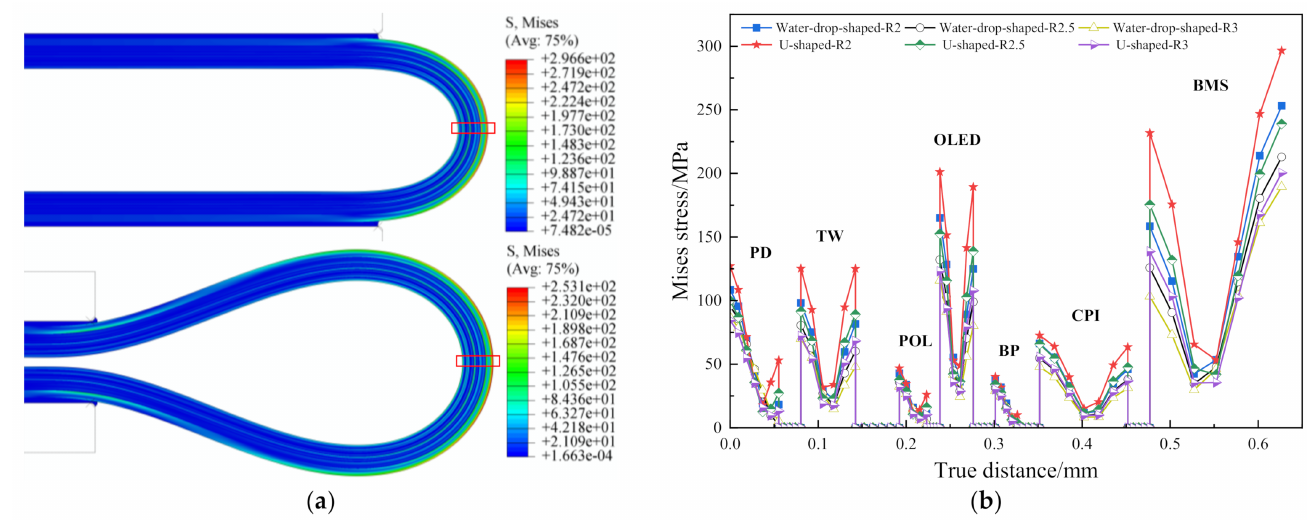
Figure 12. ( a ) Mises stress distribution for two types; ( b ) Mises stress comparison curve.